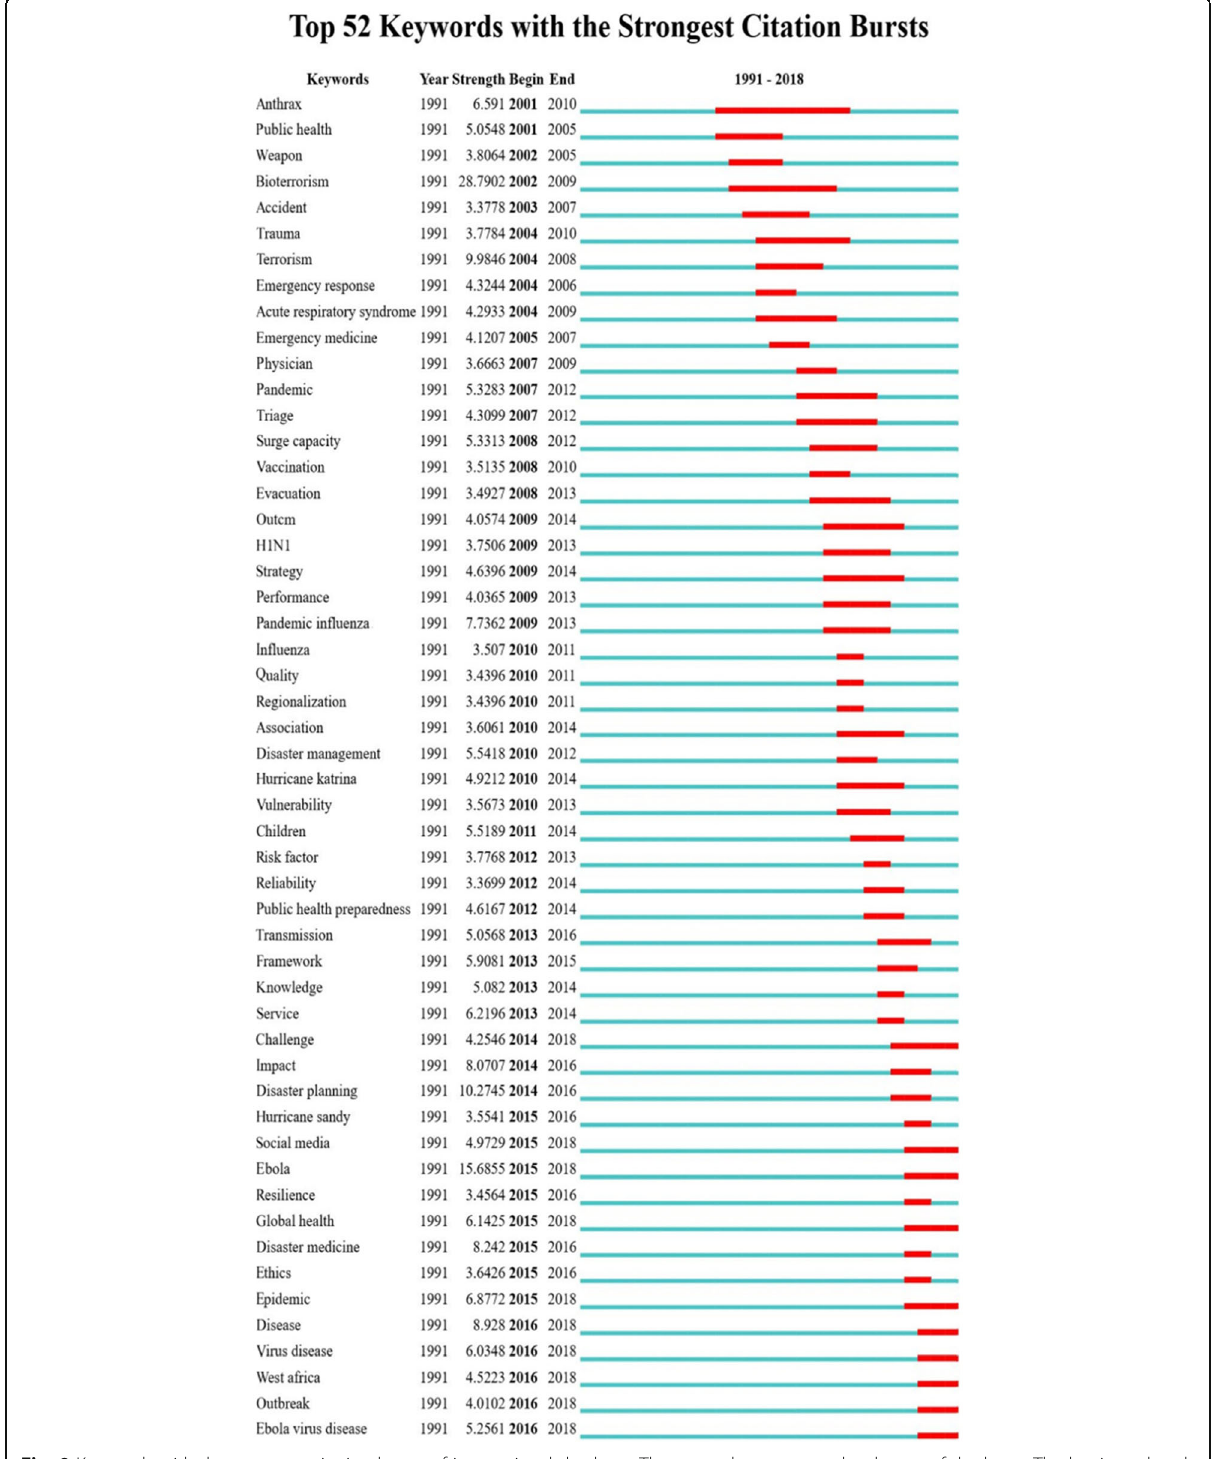
Fig. 9 Keywords with the strongest citation bursts of international database. The strength represents the degree of the burst. The begin and end represent the boundaries of the time period of the burst. The blue line is the time interval, the red line segment is the duration of the burst for one